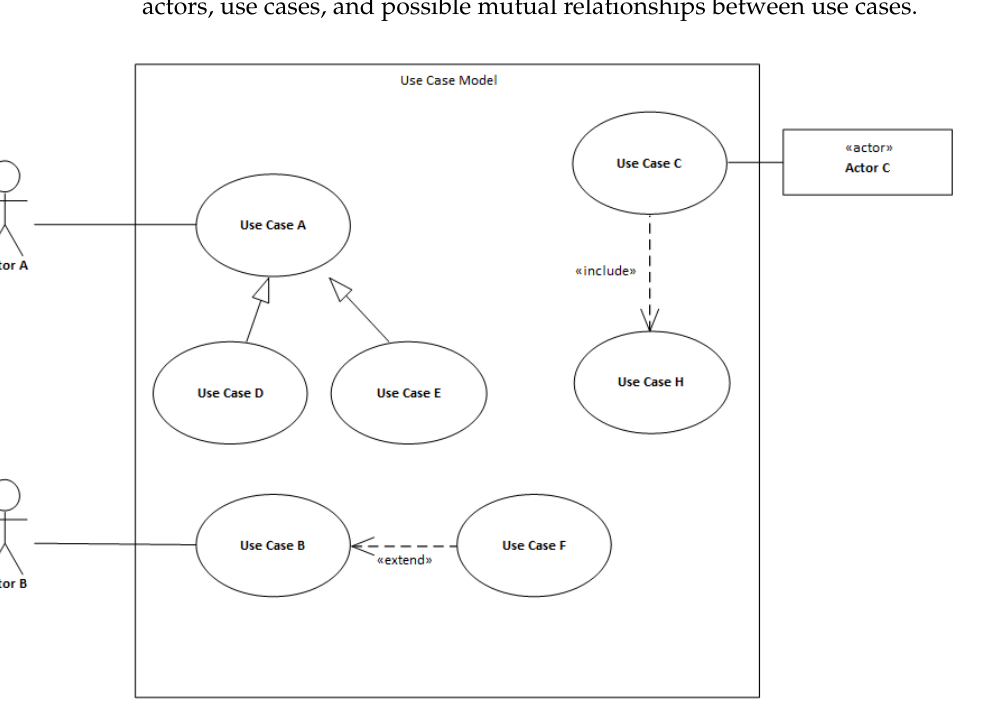
Figure 1. Demonstration of use case model.